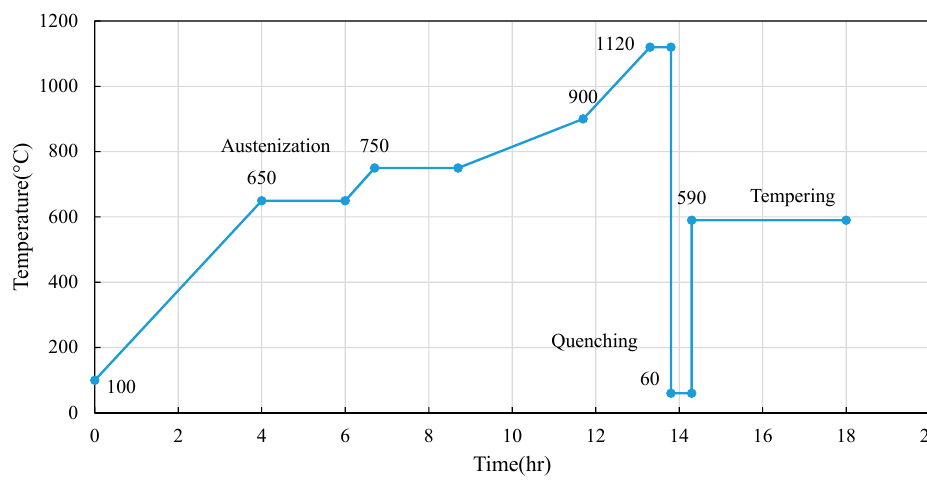
Figure 4. The heat-treatment process conditions of HTCS-150 steel.